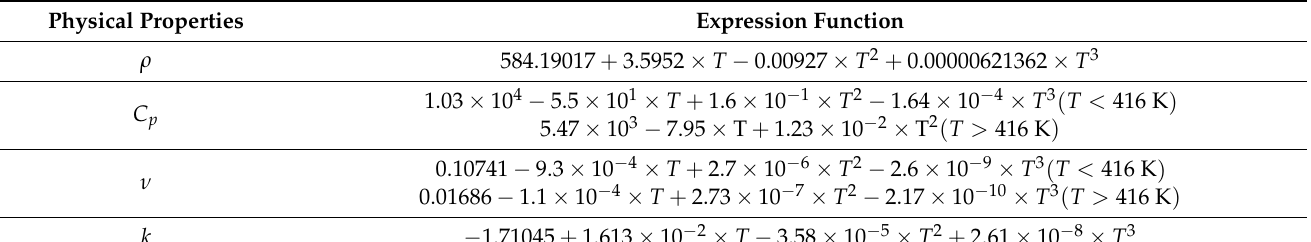
Table 1. Physical properties of cooling water.